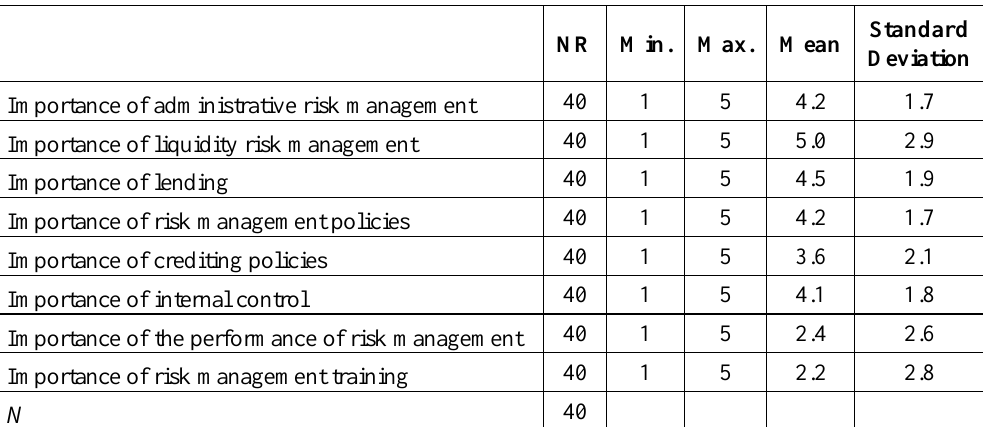
Table 2. Mean and standard deviation [table made by